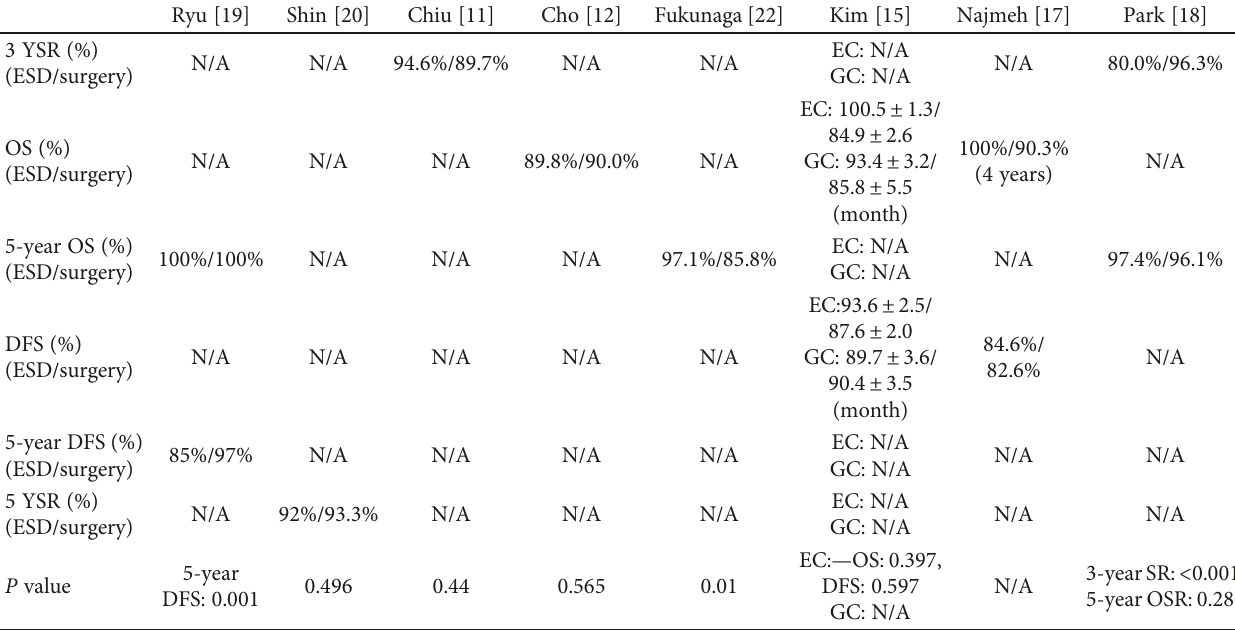
Figure 4: Forest plots showing the results of meta-analysis comparing the complete resection rate and hospital stay between patients with ESD and surgery. (a) Comparing the complete resection rate between ESD and surgery. (b) Comparing hospital-stay between ESD and surgery. ESD: endoscopic submucosal dissection. Table 2: The survival outcome of di ff erent